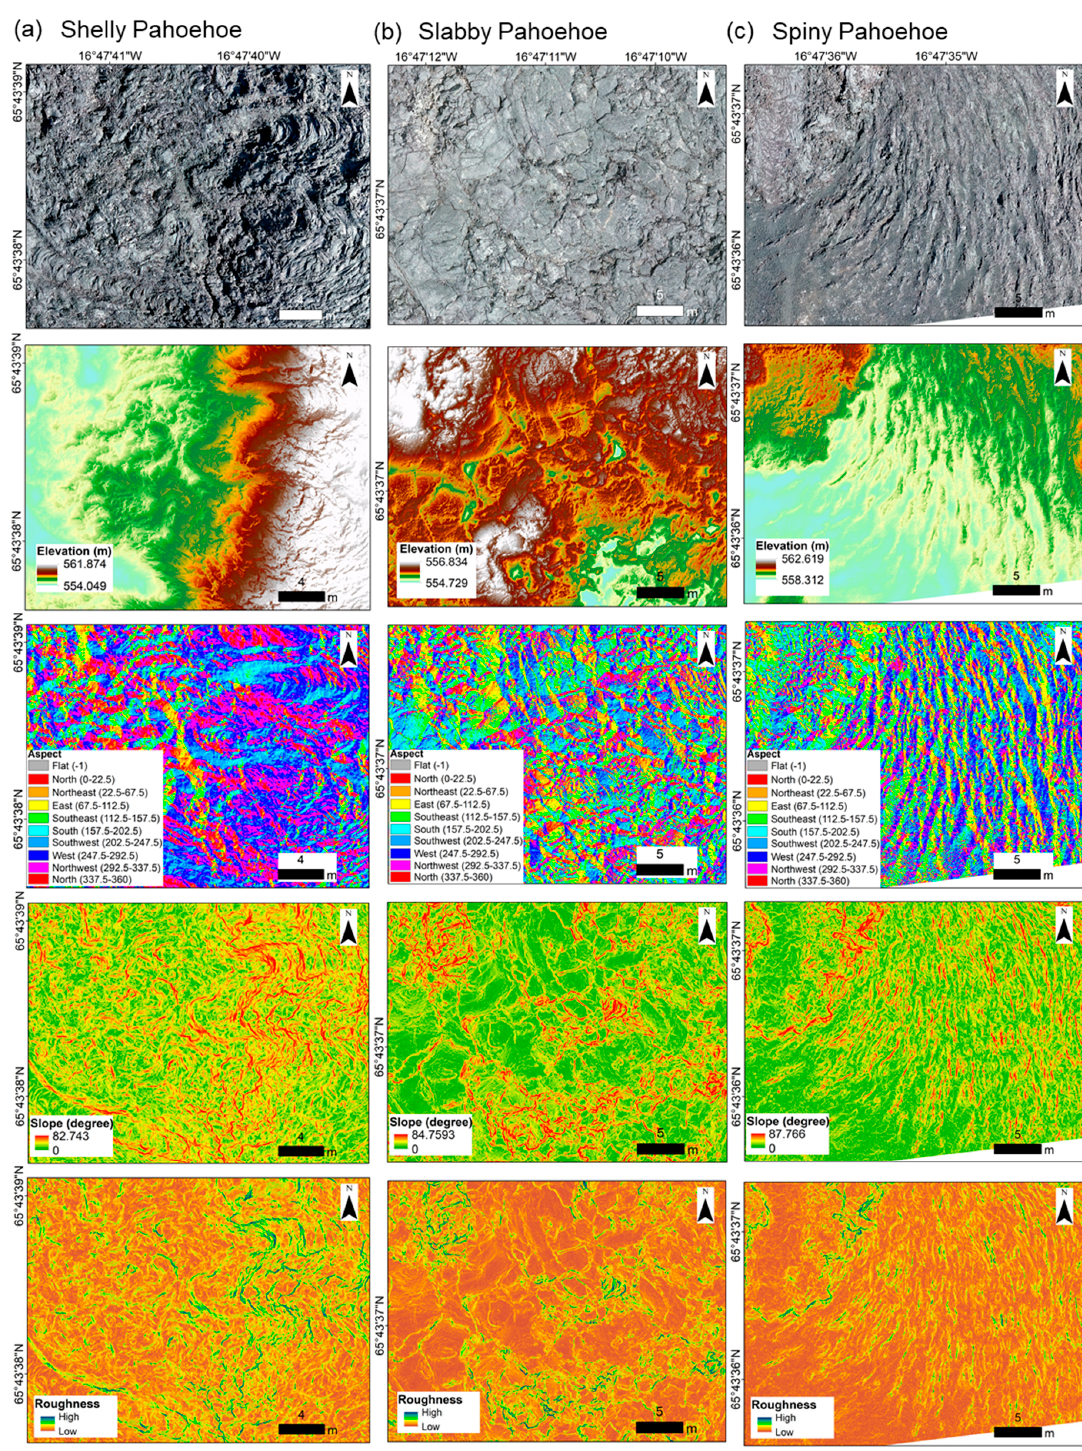
Figure 6. Lava morphologies derived from UAV imaging and photogrammetry for pahoehoe flow at Leirhnjúkur fissure volcano lava field in Krafla Caldera, Iceland: ( a ) shelly pahoehoe; ( b ) slabby pahoehoe; ( c ) piny pahoehoe. The maps represent orthomosaic, elevation, aspect, slope, and roughness in top-to-bottom order.